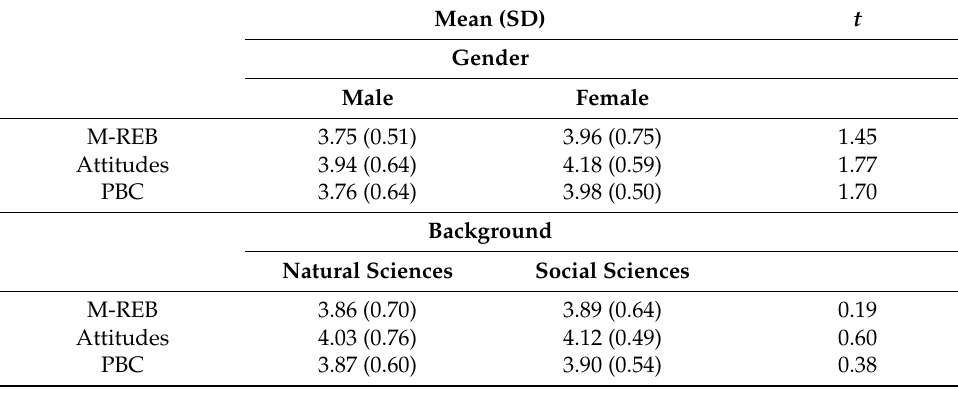
Table 5. T -test of the demographic factors ( t -value).